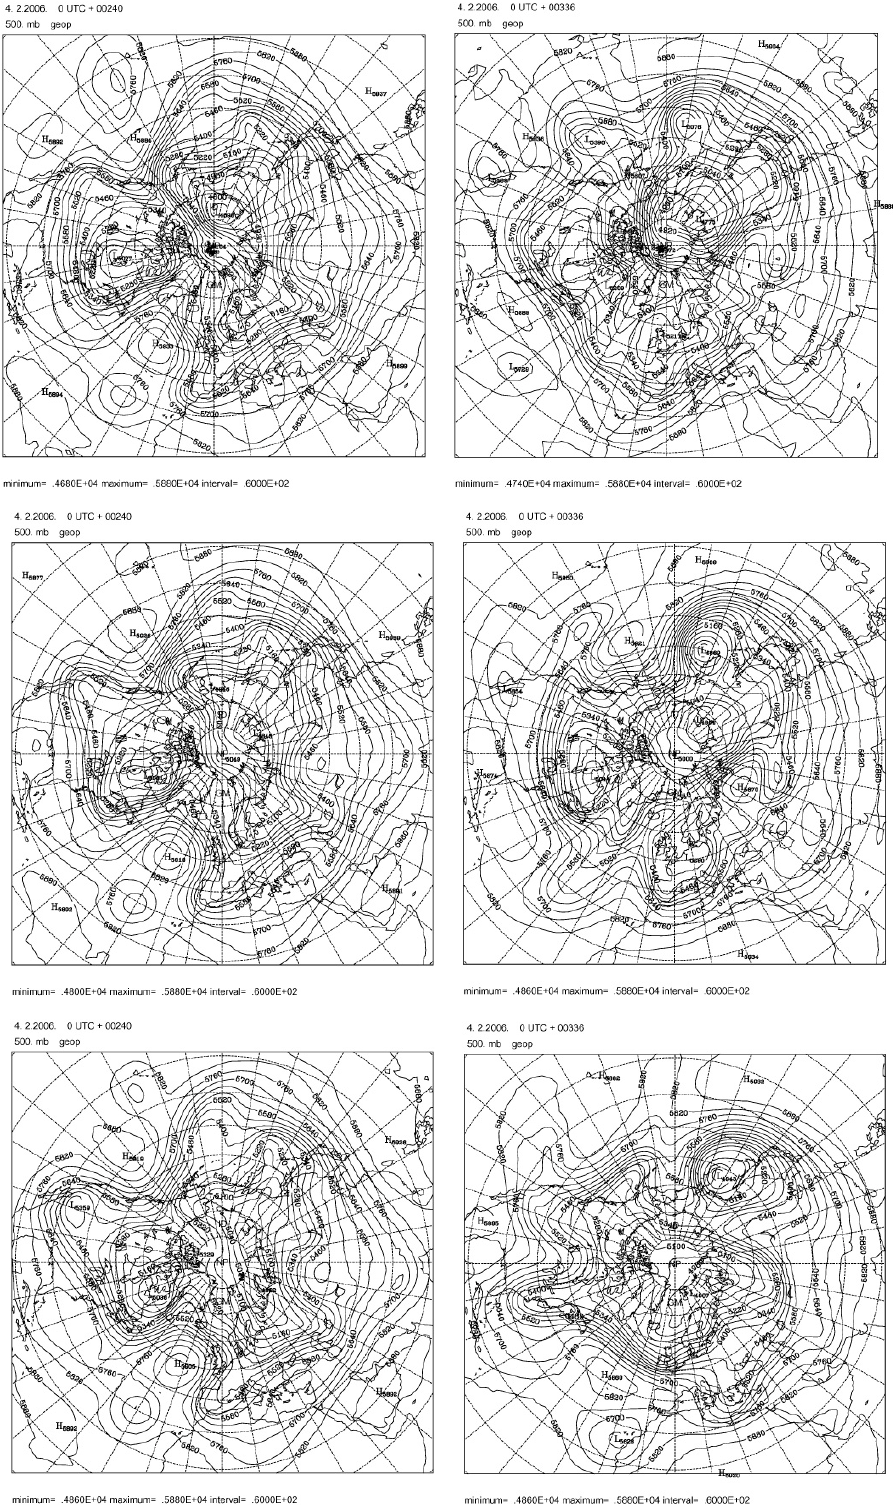
Figure 1. 10-days forecasts (left) and 14-days forecasts (right) of geopotential at 500hPa for a = 6376000m (top), a = 6375999m (middle) and a = 6344000m